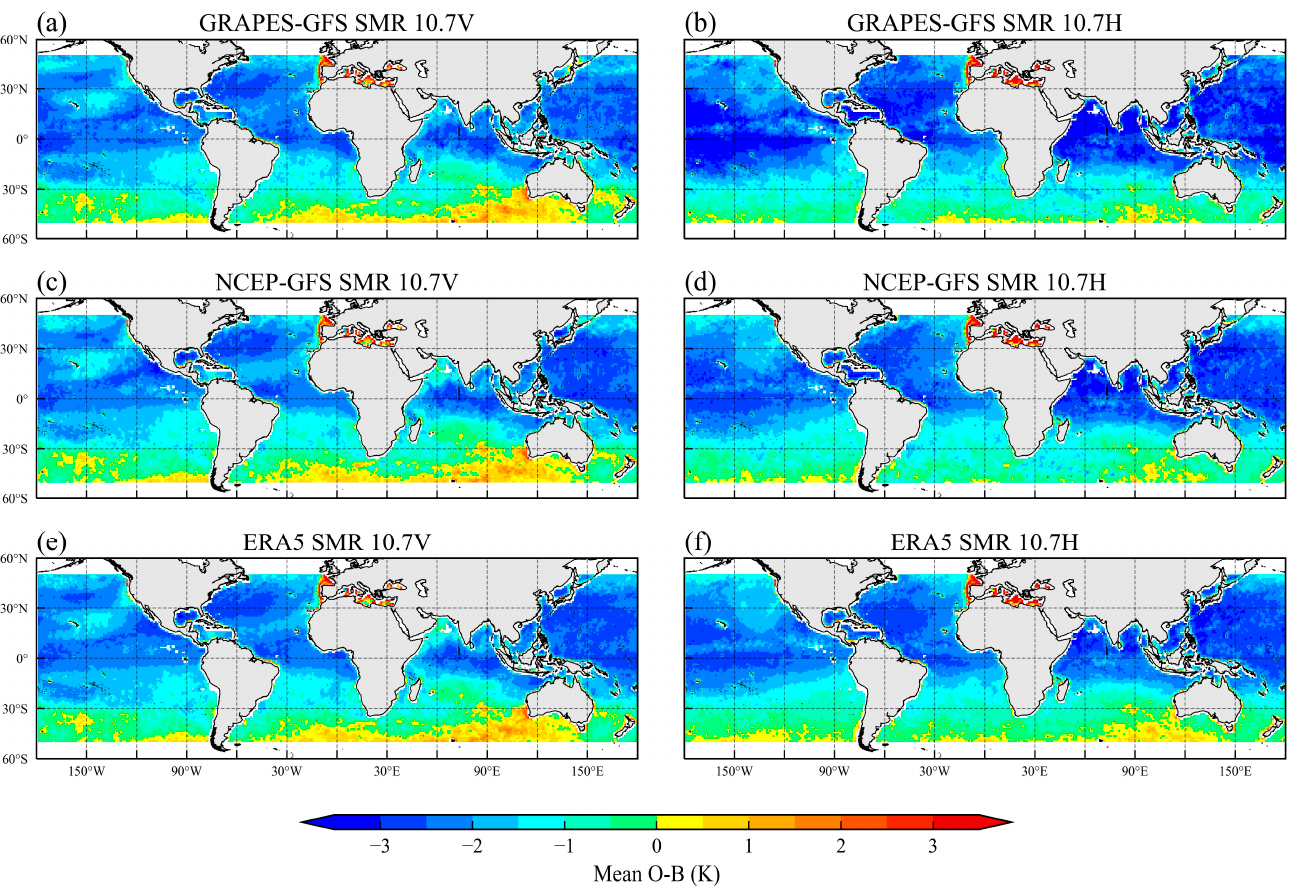
Figure 8. Spatial distribution of O-B over one month (from 10 July 2021 to 10 August 2021) for ( a ) GRAPES-GFS, SMR 10.7 V channel, ( b ) GRAPES-GFS, SMR 10.7 H channel, ( c ) NCEP-GFS, SMR 10.7 V channel, ( d ) NCEP-GFS,SMR 10.7 H channel, ( e ) ERA5, SMR 10.7 V channel, ( f ) ERA5, SMR 10.7 H channel. All statistics were calculated after applying the QC procedures described in Section 2.4.